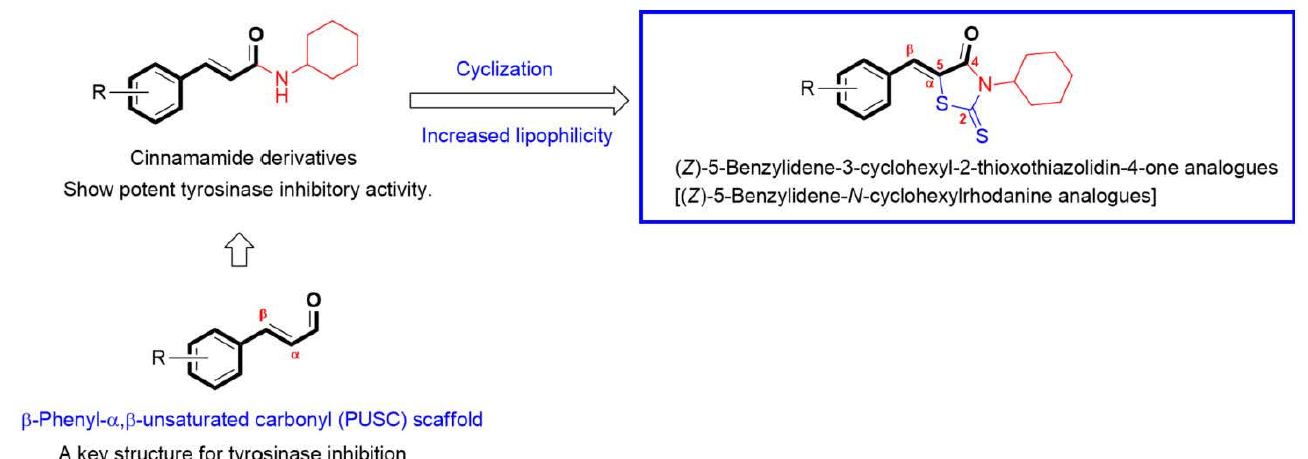
Figure 1. Rationale for the synthesis of ( Z ) ‐ 5 ‐ benzylidene ‐ 3 ‐ cyclohexyl ‐ 2 ‐ thioxothiazolidin ‐ 4 ‐ one analogs and the chemical structure of the β‐ phenyl ‐α , β‐ unsaturated carbonyl (PUSC) scaffold.